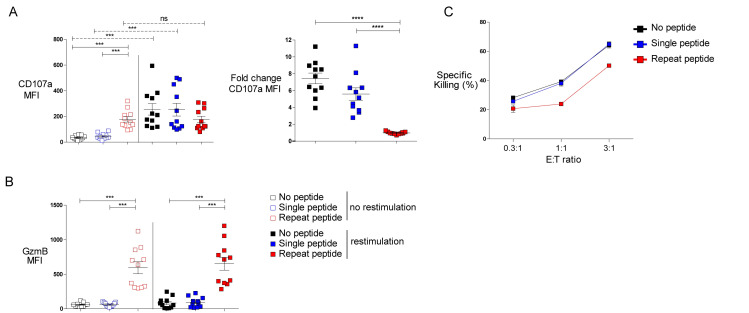
Repeat peptide stimulated CD8+ T cells have decreased cytotoxic function.On day 5, cells were harvested and re-stimulated with OVA peptide. (A) Median fluorescence intensity (MFI) of the degranulation marker, CD107a, shown (left panel). Fold change of CD107a MFI induced by peptide re-stimulation depicted on the right panel. (B) MFI of Granzyme B (GzmB) depicted for the different culture conditions. Each symbol represents one animal (n = 11–12), 9 independent experiments performed. (C) No peptide, single peptide and repeat peptide stimulated cells were co-culture with target cells (OVA-pulsed AE-17 cells) at different ratios. Percentage of specific killing is depicted. One of five independent experiments shown. Line depicts mean ± SE. Between the groups, Student’s t test with Welch’s correction was performed except for CD107a MFI (Wilcoxon signed rank test). *<0.05, **P<0.01, ***P<0.001, ****P<0.0001.